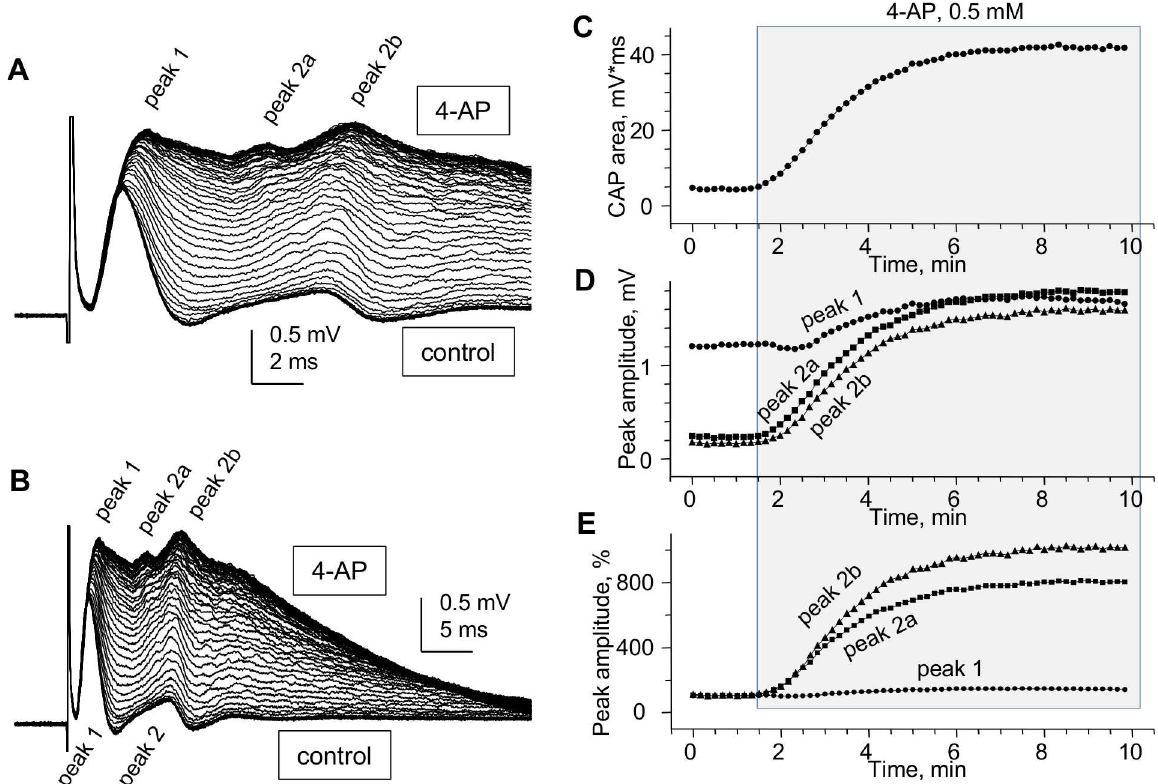
Fig 8. Pronounced effectsof potassium channel blocker 4-aminopyridine (4-AP) on “whole” CC CAPs. (A and B) Superimposed “whole” CC CAPs recordedfrom CC6 duringadministration of 0.5 mM 4–AP, shown at two different time scales to illustratethe pronouncedprolongation of CAP decay. Note the two visuallyidentifiableslow peaks (peak 2a and peak 2b) at the maximal effect of 4-AP, emerging by gradualchangesof peak 2 shapefrom control to 4-AP. The CAPs were recorded without averagingto reflect the fast changesduringthe test. (C-E) Time course of changesof CAP area (C) and peak amplitude(D, absolute; E, normalized) duringadministration of 4-AP. The half-maximum of the effect of 4-AP was reachedwithin 3.5–4 minutes. The effects were reversible(not shown). Room